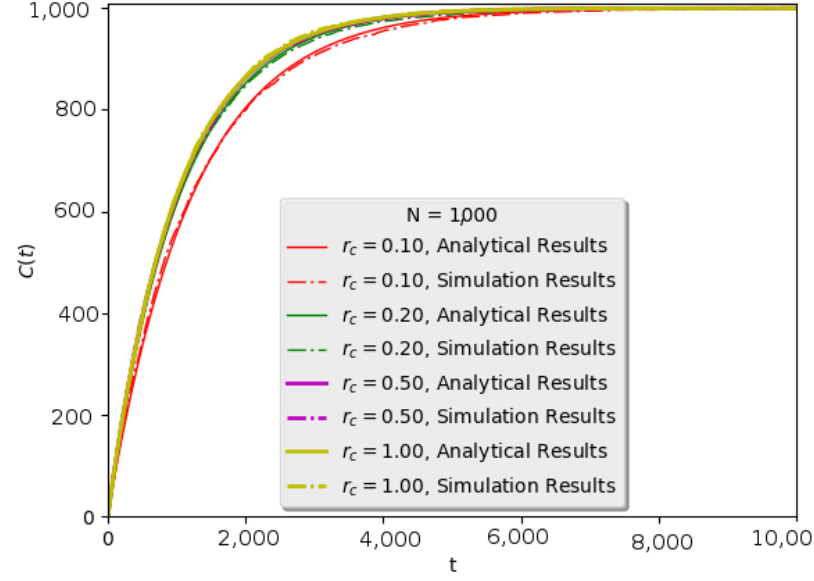
Figure 8. Simulation results for networks of various densities of links N = 1000, r c = 0.100 (red), 0.200 (green), 0.500 (magenta), 1.000 (yellow), number of neighbors = 35,158,834, 997. It depicts the coverage over the number of time steps. Full lines are for the analytic results and dashed for simulation results. Similarly to previous outcomes, the modeling is in accordance with the simulation. Moreover, it is clear that there is a difference only in the case of marginally-connected networks with the minimum value for radius r c